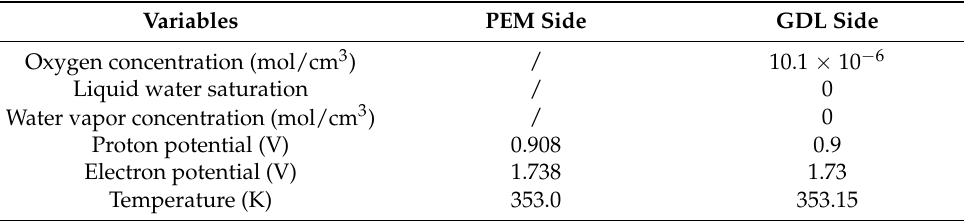
Table 3. Boundary conditions and initial